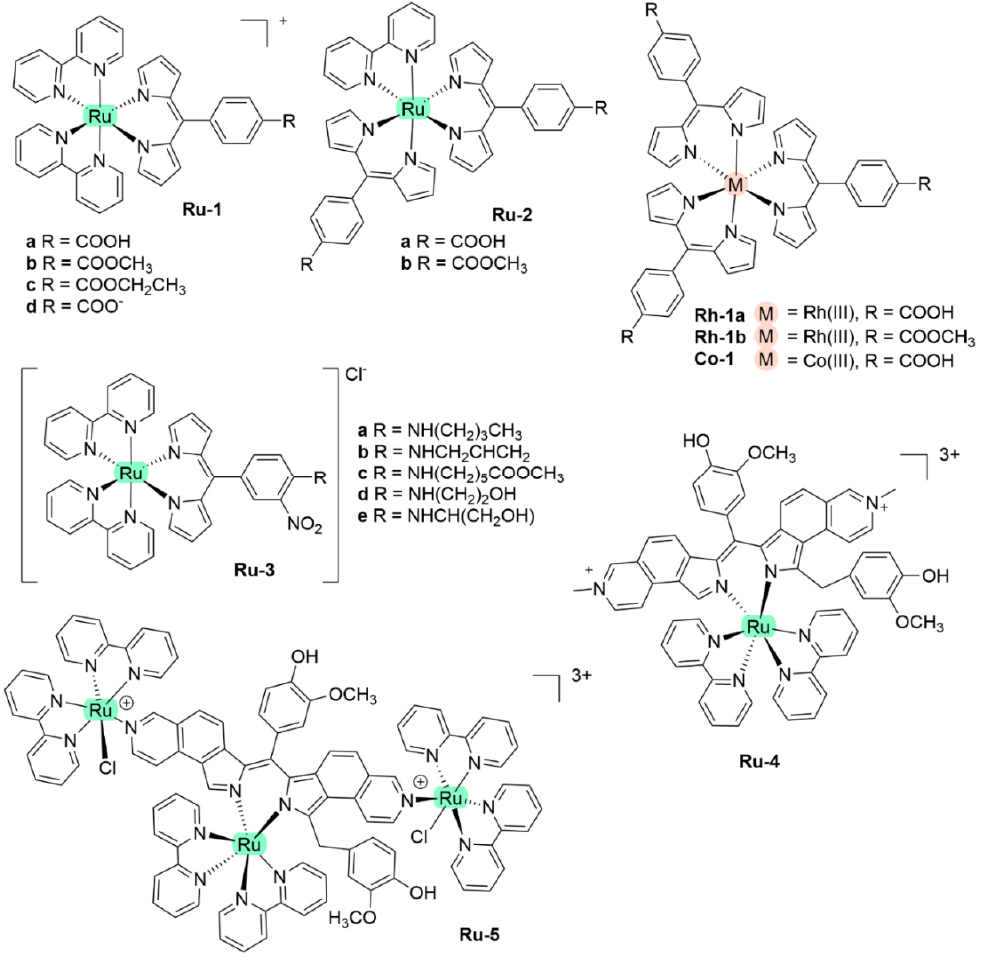
Figure 12. Examples of reported (dipyrrinato)Ru(II) and -Rh(III)-based complexes.